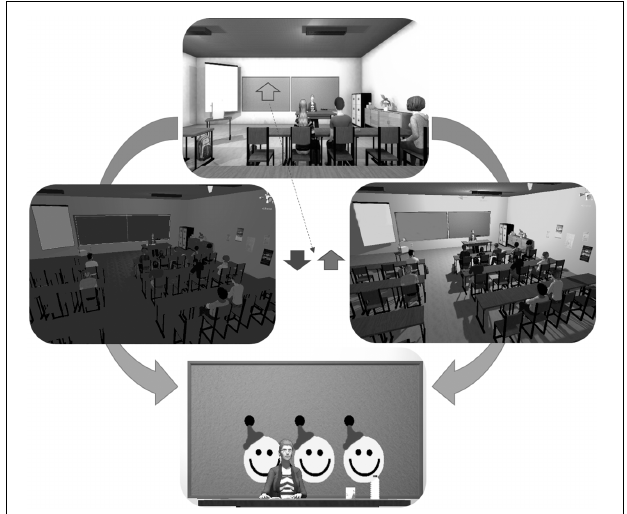
FIGURE 1 | The virtual reality classroom scenario. The top image depicts the view from the participant’s head-mounted display (HMD). An arrow pointing either up or down was displayed on the chalkboard. If the arrow pointed downward, the participant should decrease the lighting in the classroom. If it pointed up, the participant should increase the lighting in the classroom. If the participant performed the task adequately, they would receive one to three smileys, presented on the chalkboard, based on the duration of success.